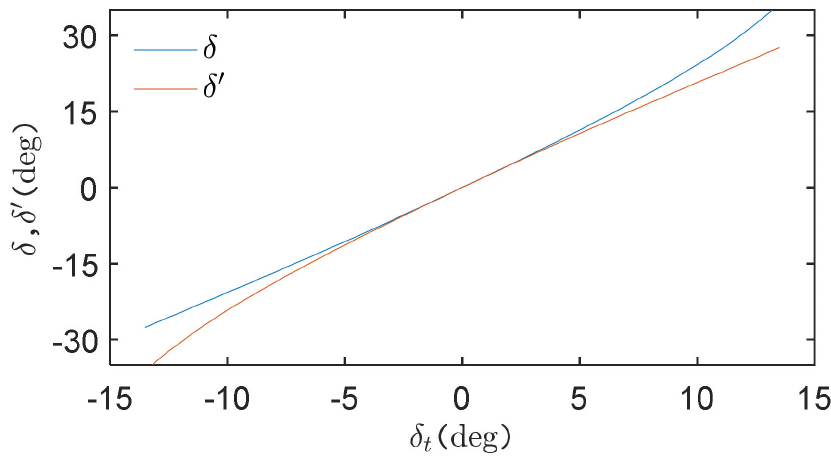
Figure 4. Simulation without tilting.